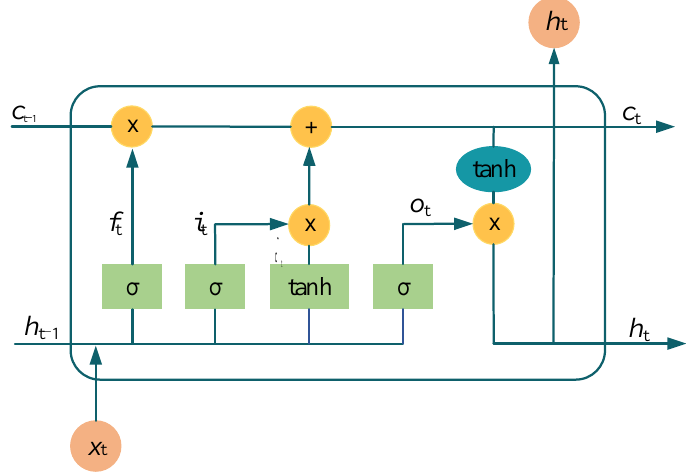
Figure 5. The network structure of the LSTM.